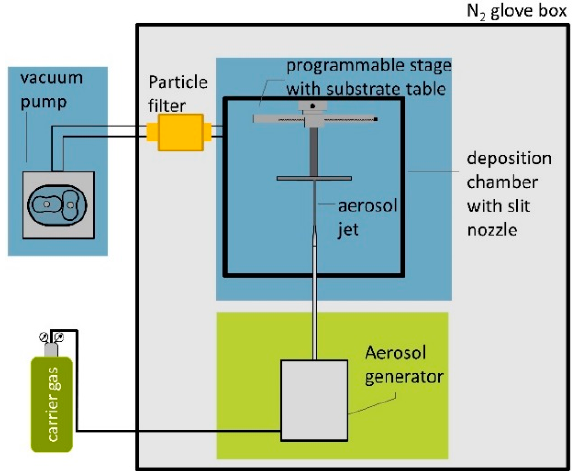
Figure 1. Schematic of AD device setup used for the brush generator experiments.